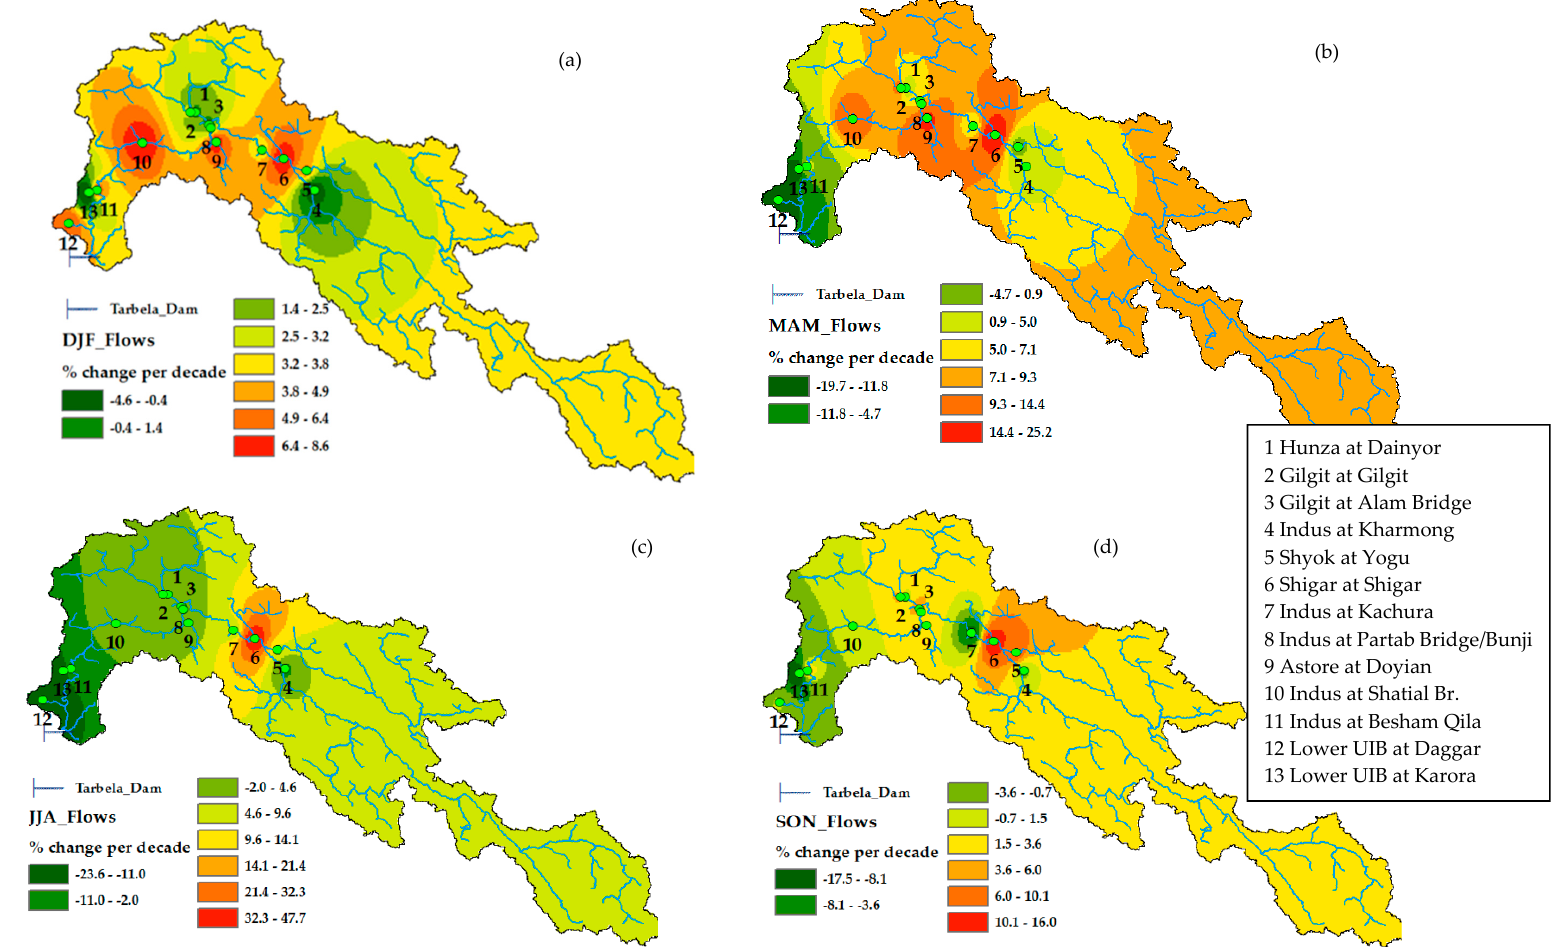
Figure 2. Seasonal flow trends spatially distributed over the basin with % of changes per decade in % of mean values for the whole period. ( a ) DJF (winter), ( b ) MAM (spring), ( c ) JJA (summer), ( d ) SON (autumn) seasons.